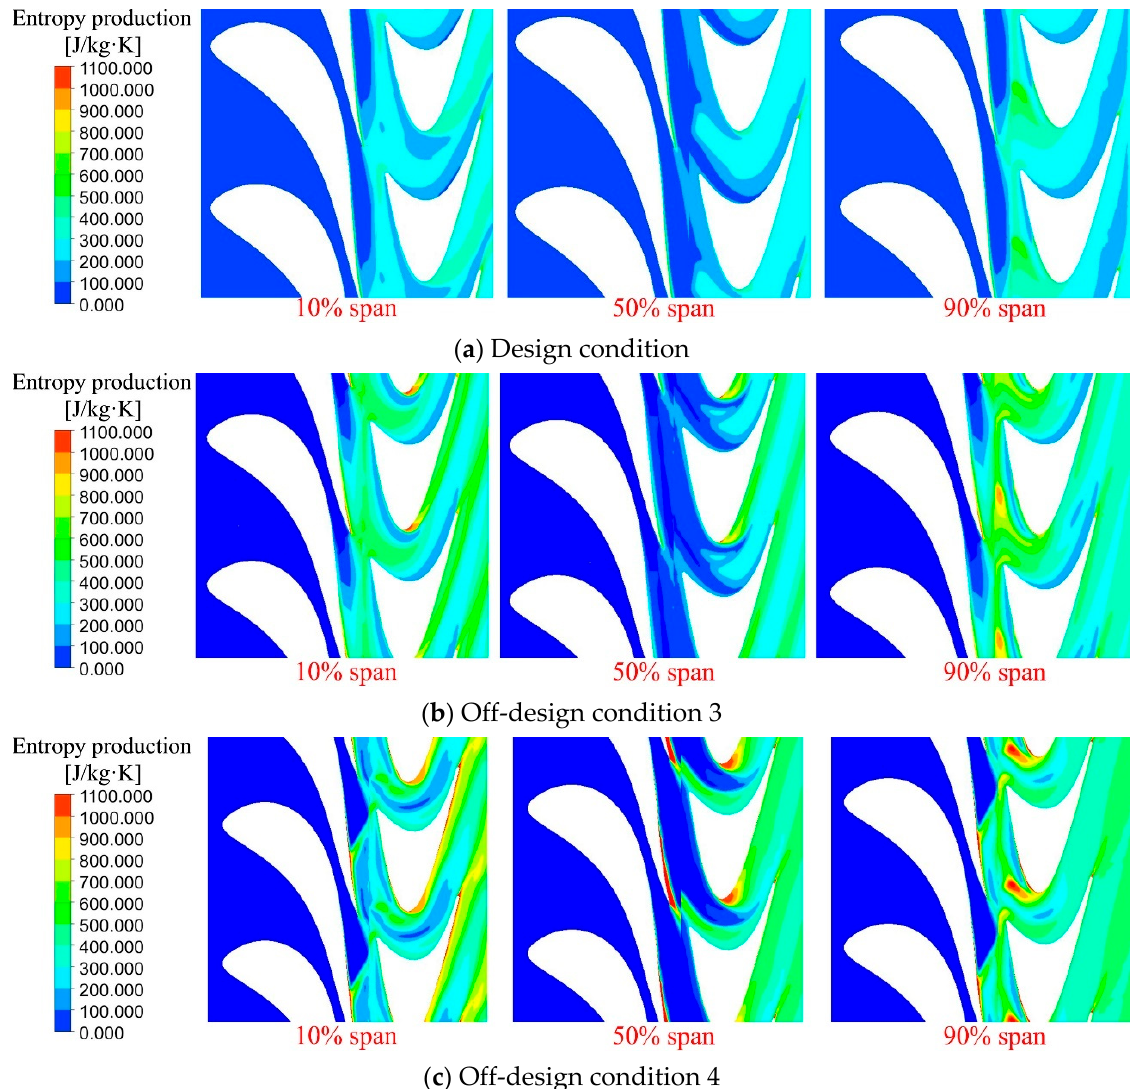
Figure 9. Entropy production of 50% span at design and off-design conditions.